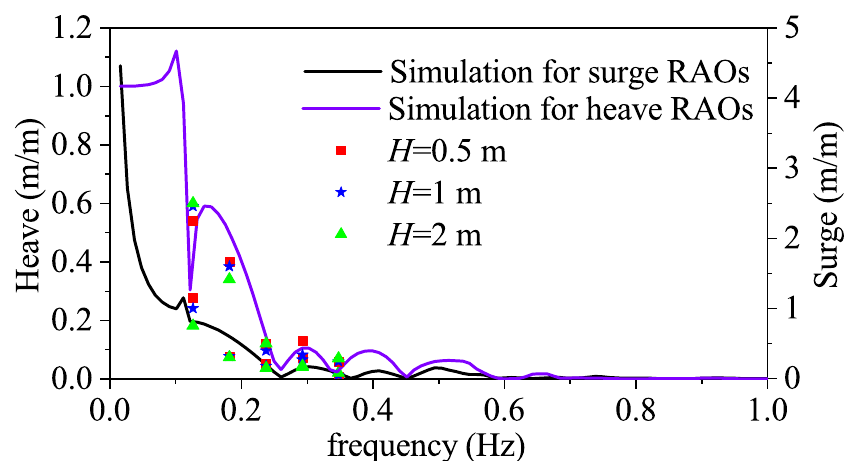
Figure 13. Surge and heave RAOs comparison between the simulation and